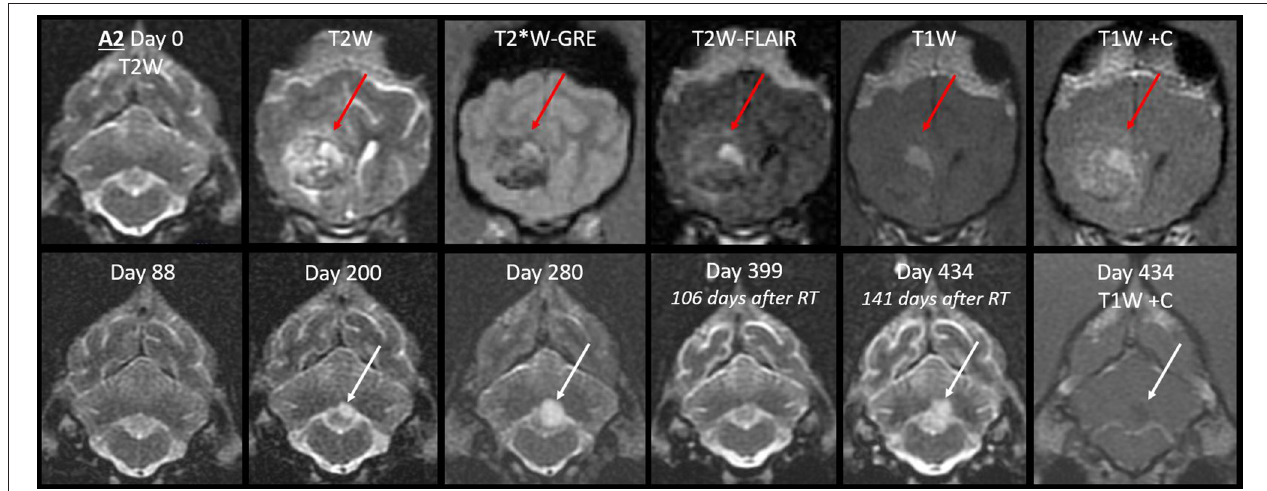
FIGURE 9 | Progression of the cerebellar lingula CSF drop metastasis, Case A2. Top row: the normal cerebellum and the primary mass before surgery (T2W, T2*W-GRE, T2W-FLAIR, and T1W pre- and post-contrast). The primary mass (red arrows) effaces the lateral ventricle and is tremendously heterogeneous, hemorrhagic, irregularly contrast-enhancing, and space-occupying. Bottom row: cerebellar lesion over time, transverse T2W, and T1W post-contrast images. Homogenous T2-hyperintense lingula lesion was first detected 6 months after surgery (white arrows). It increased in size, then resolved with whole CNS radiation therapy. On day 434, it reached its largest size and became mildly T2-heterogeneous. It was non-enhancing and mildly T1-hypointense. At no stage did it resemble the primary mass.